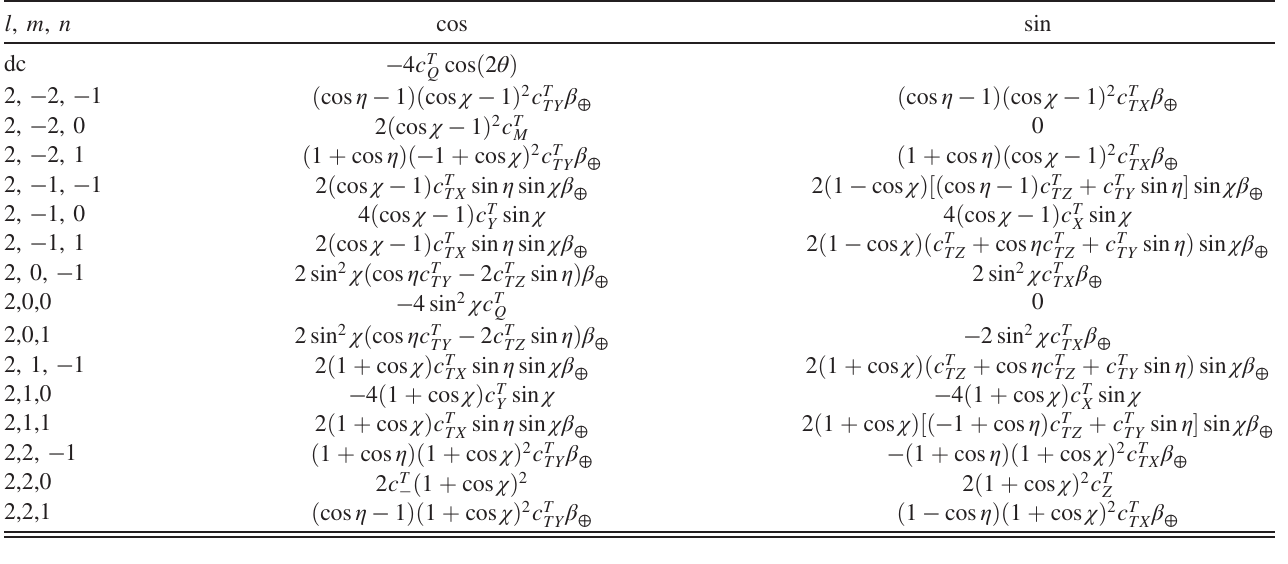
TABLE III. Signal components for an experiment with two rotating crystal oscillators compared against one another. Components suppressed by β 2 ⊕ and higher powers have been omitted. These coefficients are to be inserted in Eq. (9) and are multiplied by 1 = 8 to give the frequency